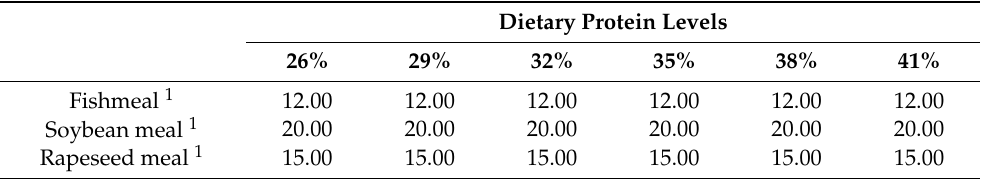
Table 1. Diet formulation of different protein levels (% dry